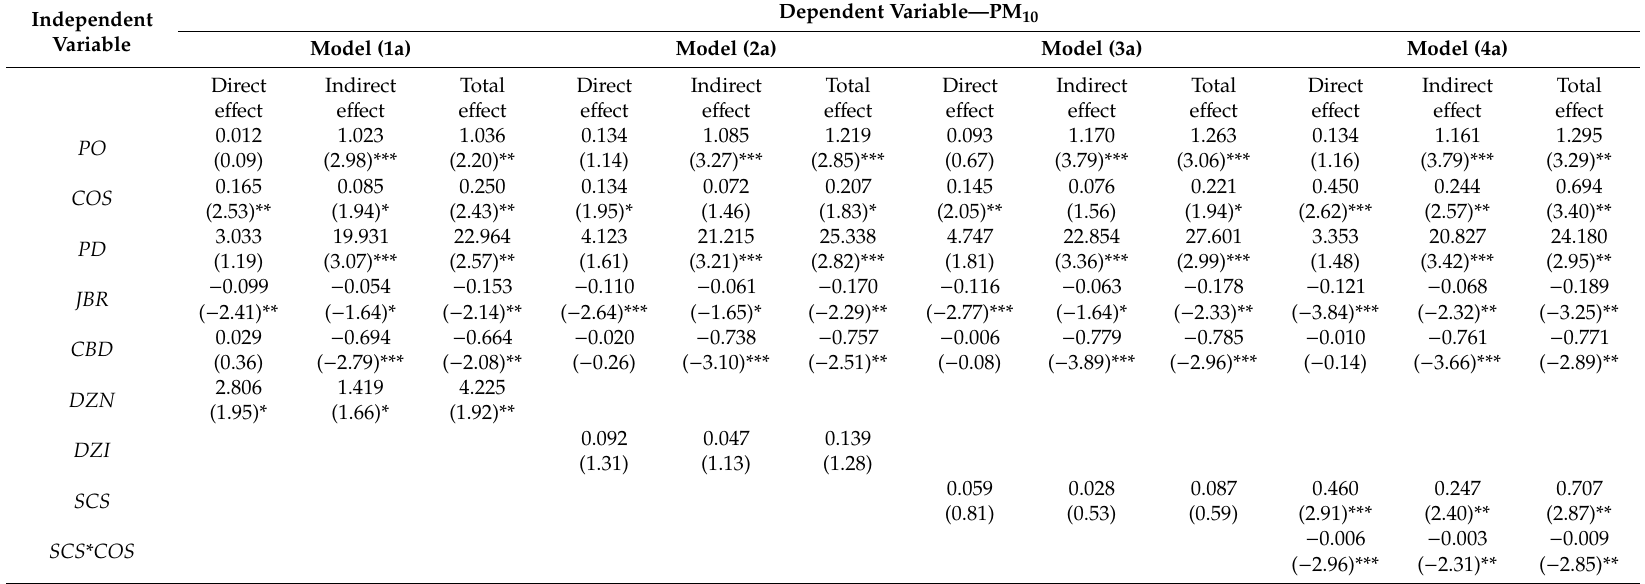
Table 5. SDM Regression results-PM